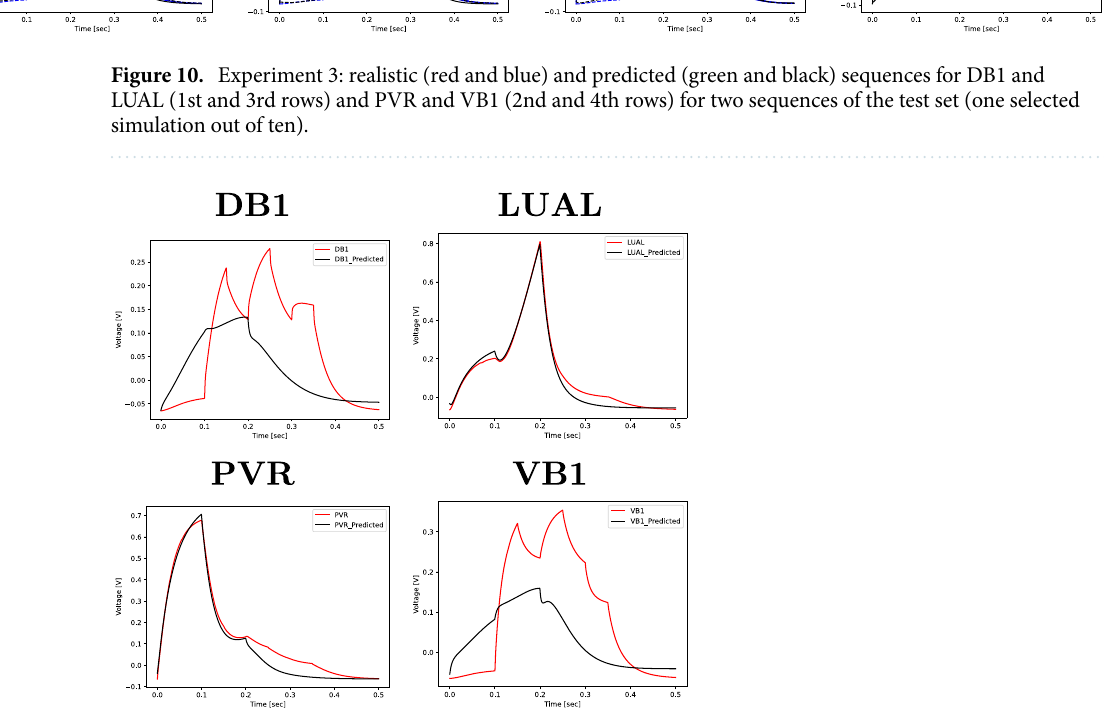
Figure 11. Experiment 4: realistic (red) and predicted (black) sequences for GRU-8 trained without input information of the AVB neurons for one sequence of the test set (one selected simulation out of